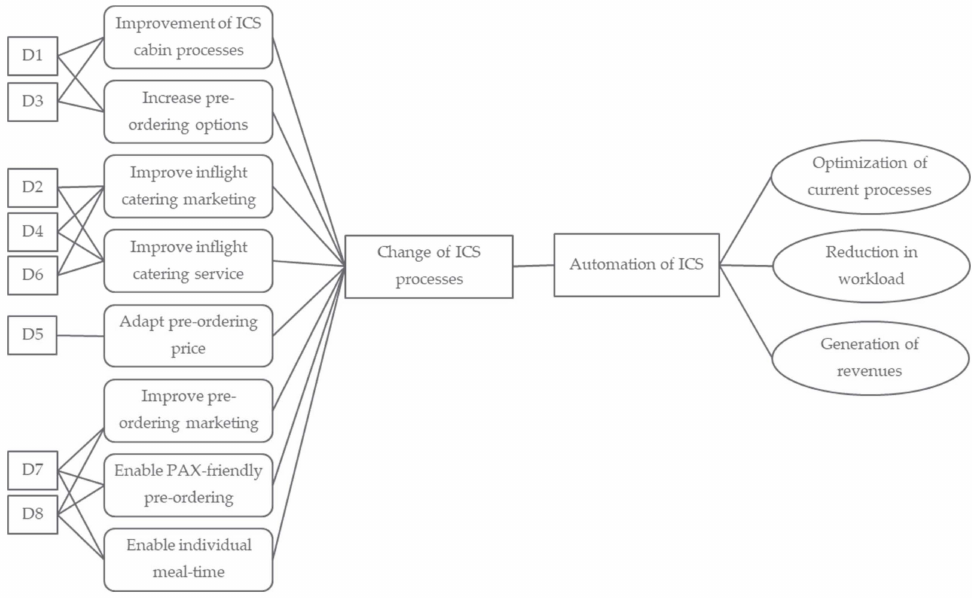
Figure 4. Dimensions-based research model for meal